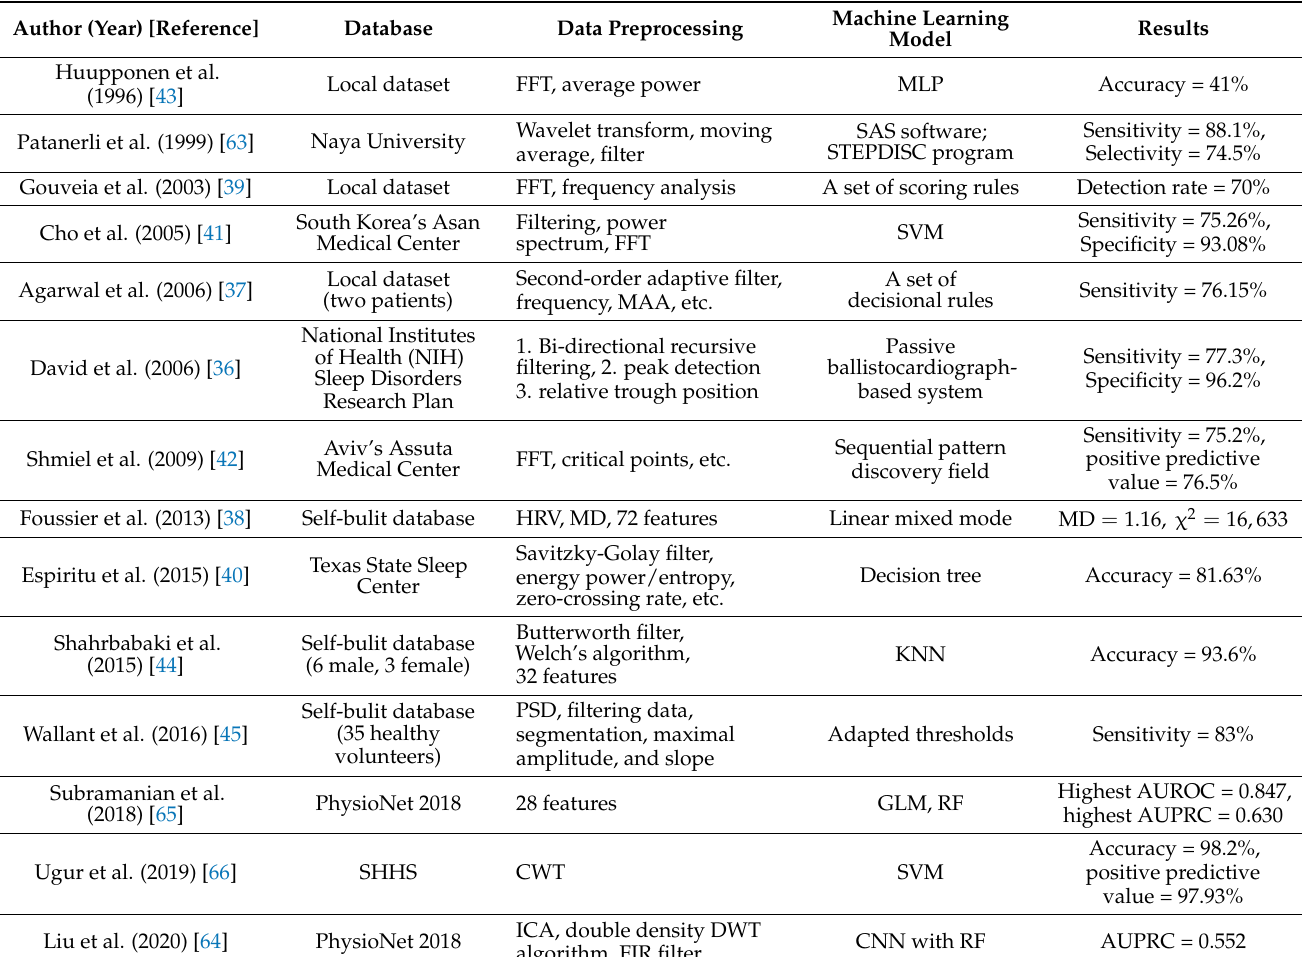
Table 3. Various studies conducted on the automated detection of microarousal regions in PSG signals using traditional machine learning